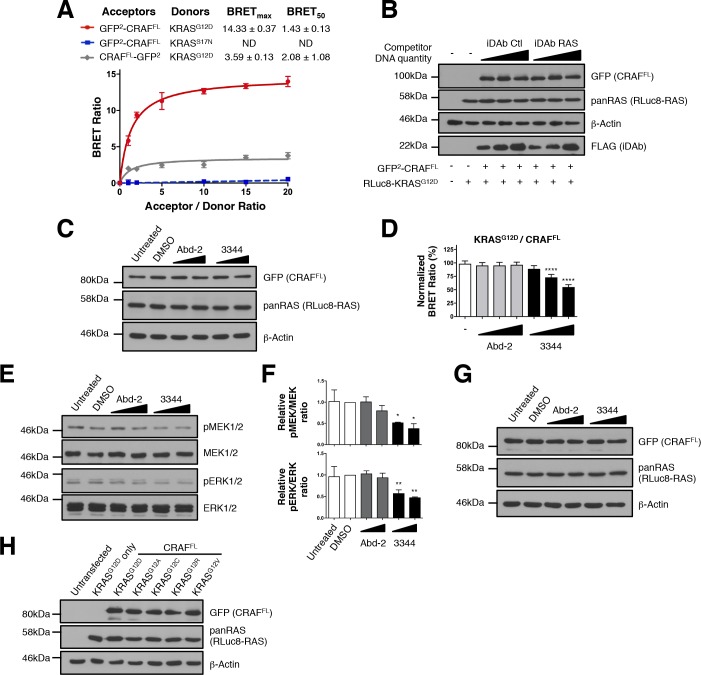
Interactions of KRASG12X mutants and full-length CRAF are inhibited by 3344.(A) BRET titration curves of KRAS mutants with full-length CRAFS257L (CRAFFL). KRASG12D interacts with GFP2-CRAFFL while it gives a low BRET ratio with CRAFFL-GFP2. The dominant negative KRASS17N does not interact with GFP2-CRAFFL showing the accuracy and optimization of this biosensor. (B) Controls from Figure 2B. The expression level of the BRET pair was assessed by western blot with the GFP (for CRAFFL) and pan-RAS (for RLuc8-KRASG12D) antibodies. iDAb expression was revealed using anti-FLAG antibody; anti-β-actin binding was used as the loading control. (C) Controls from Figure 2E. The expression level of the BRET pair was assessed with the GFP (for CRAFFL) and pan-RAS (for RLuc8-KRASG12D) antibodies, anti-β-actin binding was used as the loading control. (D–F) Short-term incubation of the compounds (3 hr) on cells transfected with the KRASG12D/CRAFFL biosensor. The BRET ratio was measured in the presence of an increasing dose of compound 3344 (D). This induces a dose-dependent decrease of MEK and ERK kinase phosphorylation (E) after cells expressing the KRASG12D/CRAFFL biosensor pair were treated 3 hr with DMSO, 10 and 20 μM of Abd-2 and 3344 compounds or not treated (untreated lane). Quantification of the relative levels of pMEK1/2 and pERK1/2, normalized to total MEK1/2 and ERK1/2 respectively, are shown in panel F. (G) Controls from panel E. (H) Controls from Figure 2G. The expression level of each BRET pair was assessed with the GFP (for CRAFFL) and pan-RAS (for RLuc8-KRASG12X) antibodies. One-way ANOVA followed by Dunnett’s post-hoc tests were used to determine the statistical significance of BRET, pERK and pMEK modulations induced by the compounds (*p<0.05, **p<0.01, ****p<0.0001). Each experiment was repeated twice (A, E–F) or three times (D). Where error bars are presented, they correspond to mean values ± SD of biological repeats (A, D) or correspond to mean ± SEM of biological repeats (F).